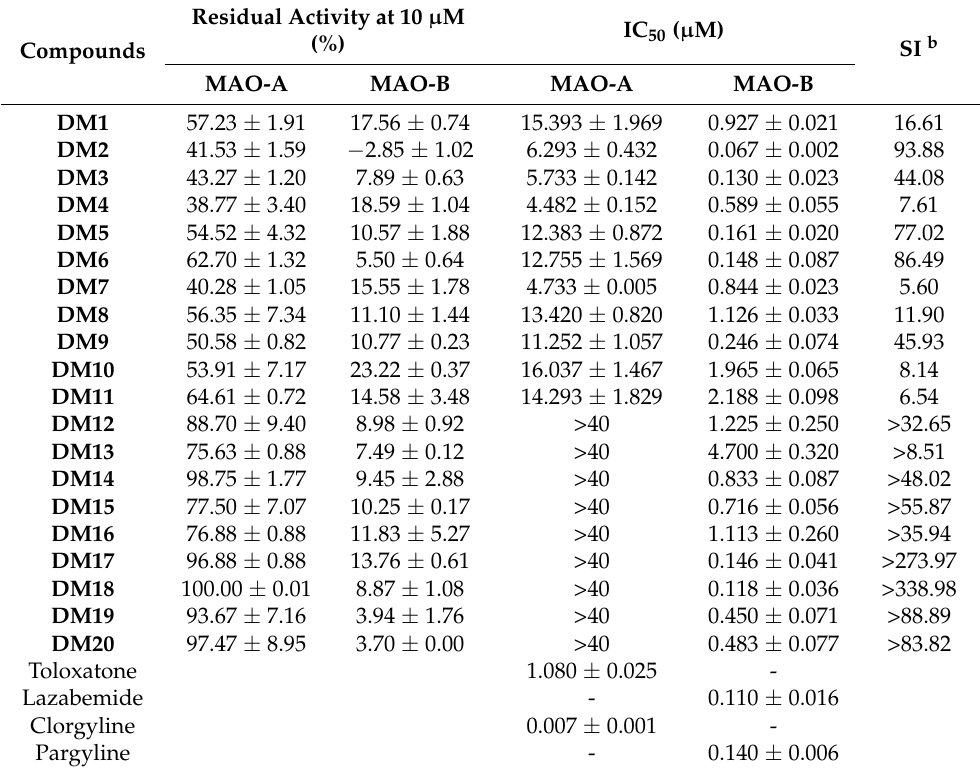
Table 1. Inhibitions of MAO-A and MAO-B by DM series a .